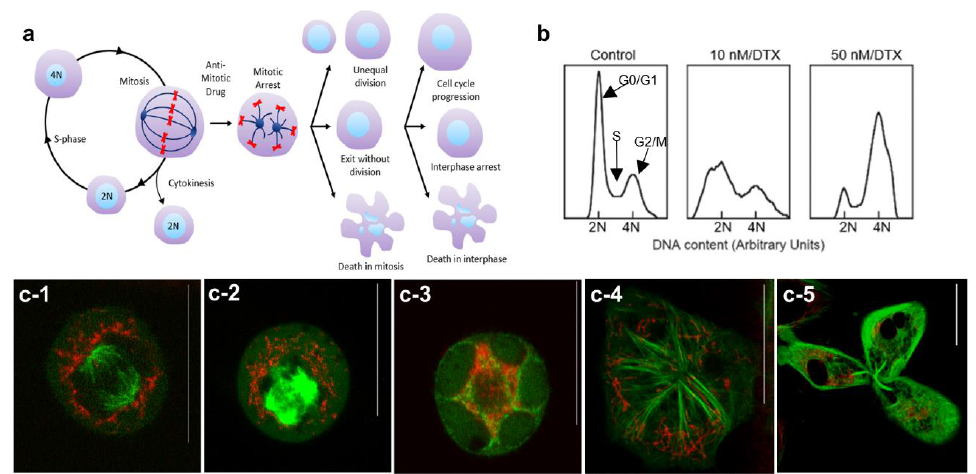
Figure 3. Distribution of NPs during cell division in the presence of DTX. ( a ) Schematic diagram illustrating the different outcomes of cell division in the presence of the antimitotic drug, DTX. ( b ) Cell cycle analysis for control cells and cells treated with 10 and 50 nM concentrations of DTX. ( c ) Distribution of NPs in a control cell ( c-1 ), cells treated with 50 nM DTX ( c-2 – c-4 ) and in a cell treated with 10 nM DTX ( c-5 ). Vesicles containing GNPs and MTs are marked in red and green, respectively. Scale bars are 20 µm.